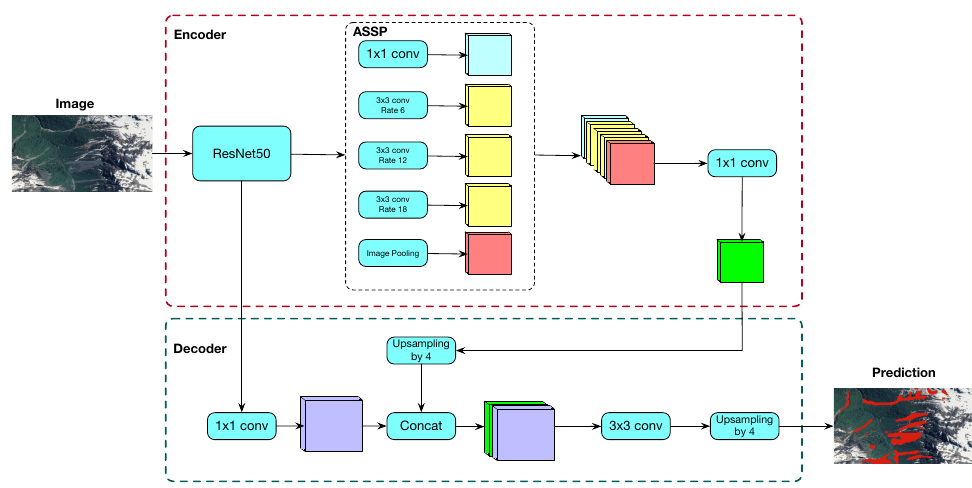
Figure 2. DeepLabV3+